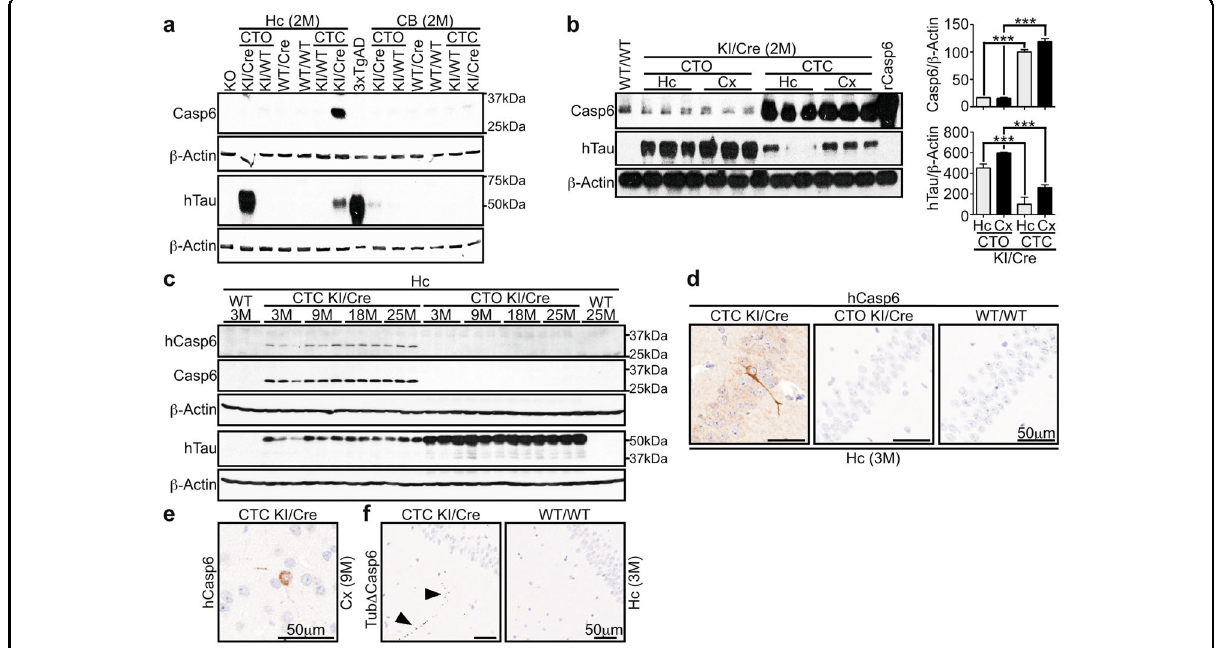
Fig. 1 Speci fi c co-expression of active hCasp6 with hTau in the cortex and hippocampus of CTC KI/Cre mice. Western blot with 15 μ g total proteins from ( a, b ) 2 month (M) old and ( c ) 3 – 25-month-old CTO KI/Cre, CTO KI/WT, WT/Cre, WT/WT, CTC KI/WT, or CTC KI/Cre hippocampus (Hc), cerebellum (CB), or cortex (Cx) with anti-Casp6, anti-hTau, anti-hCasp6, and anti- β -Actin antibodies. In a , proteins from Casp6 KO hippocampus or Tau KO brainstem (KO) were used as negative controls for Casp6 and Tau analyses, respectively. Cx proteins from 3xTgAD were used as positive control for hTau. In b , the histograms represent densitometric analyses of the western blot shown. Data are expressed as ratios of Casp6 or hTau over β -Actin, relative to CTC KI/Cre hippocampus ( n = 3/genotype/structure). One-way ANOVA followed by Bonferroni ’ s post-hoc test was performed. *** p < 0.001. d-f Representative micrographs from n = 5/genotype/structure/age/antibody for 3 M hippocampus ( d ) and 9 M cortex ( e ) with anti-hCasp6, and 3 M hippocampus with anti-Tub Δ Casp6 ( f